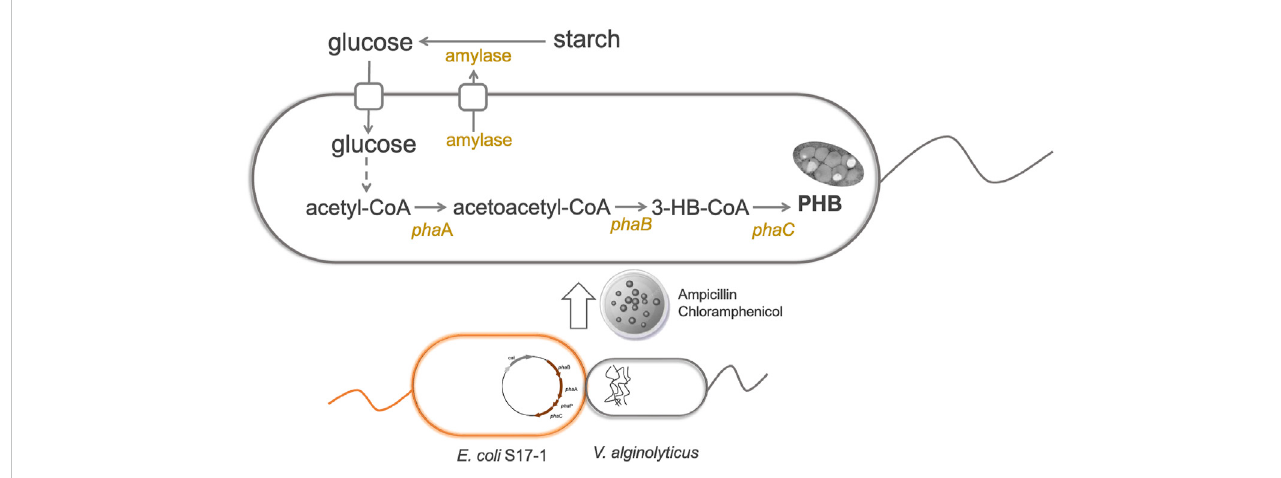
FIGURE 3 Construction of a genetic manipulation platform for improved PHB production in V. alginolyticus LHF01.